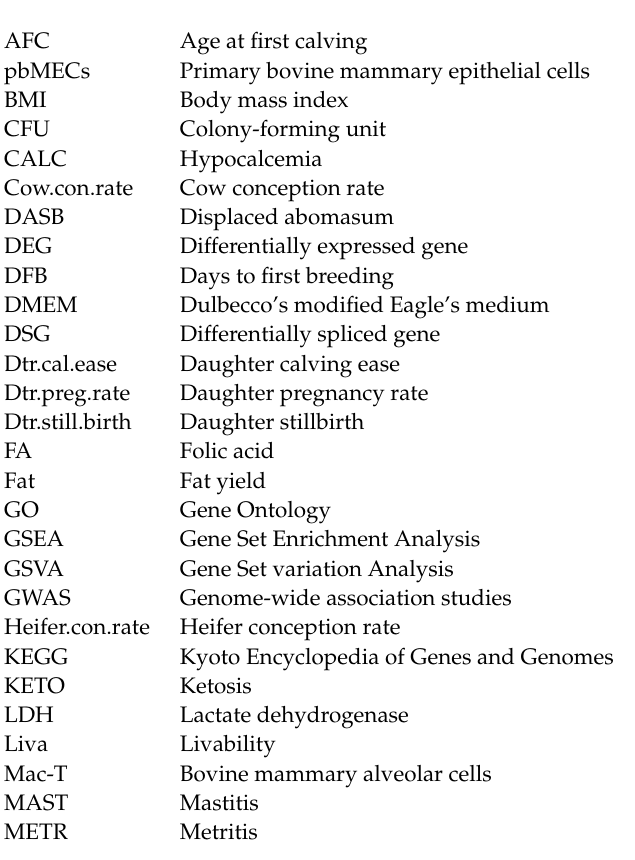
Table S1: Reads summary. Table S2: WGCNA modules. Table S3: DEGs summary. Table S4: DEGs and DSGs details. Table S5: Modules and gene sets used for GWAS enrichment. Table S6: GWAS enrichment. Table S7: PheWAS